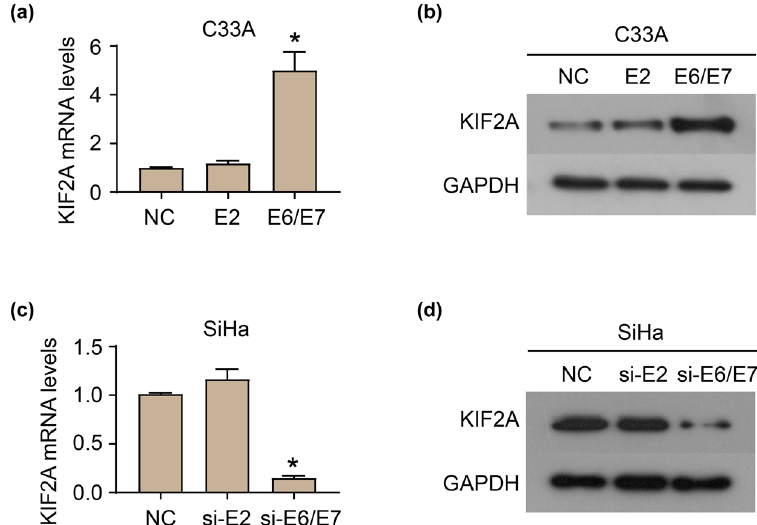
Figure 2: HPV16 E6E7 up - regulates KIF2A expression. mRNA ( a ) and protein ( b ) levels of KIF2A in C33A cells heterogenous expressed HPV E6E7. mRNA ( c ) and protein ( d ) levels of KIF2A in SiHa cells which endogenous E6/E7 was reduced by siRNA deletion. * P <